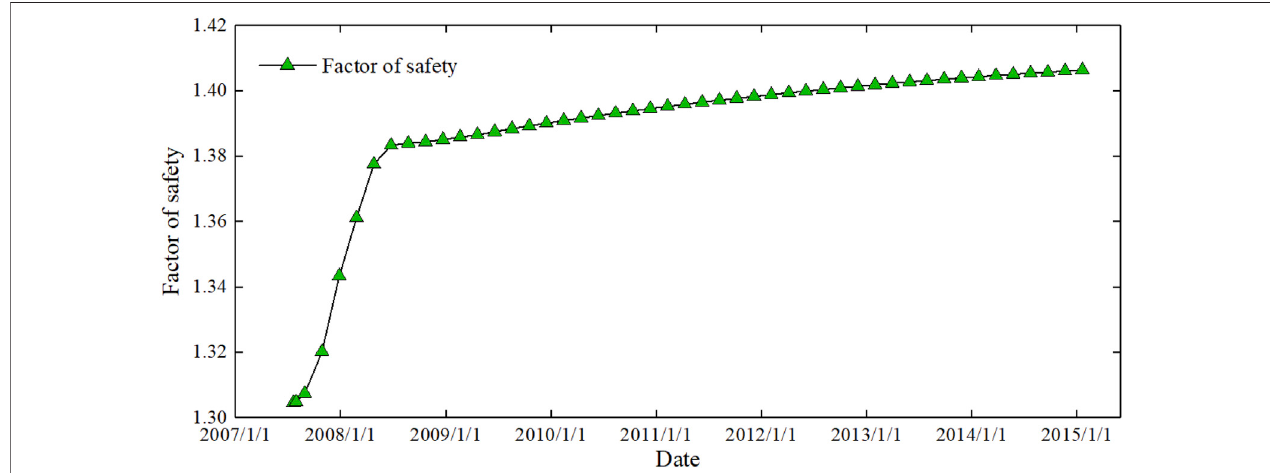
FIGURE 11 | Ephemeral safety coef fi cient curve of left bank slope stability.